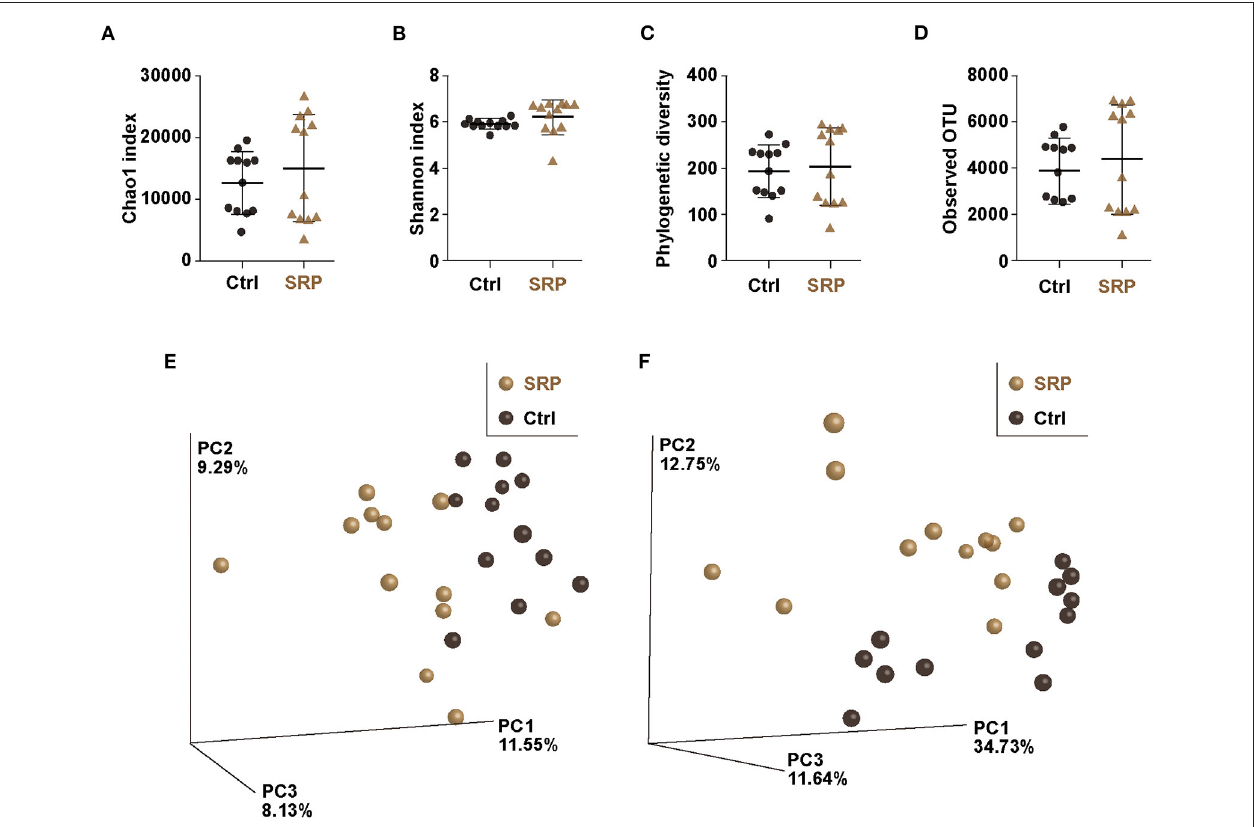
FIGURE 2 | The α - and β -diversity indices of the cecal microbiota. The Chao1 index (A) , Shannon index (B) , phylogenetic diversity (C) , and observed OTUs (D) were calculated for the Ctrl and SRP groups [ n = 12; values are expressed as the mean (SD)]. β -Diversity by weighted (E) and unweighted (F) UniFrac was assessed as the distance metric between the Ctrl and SRP groups ( n =